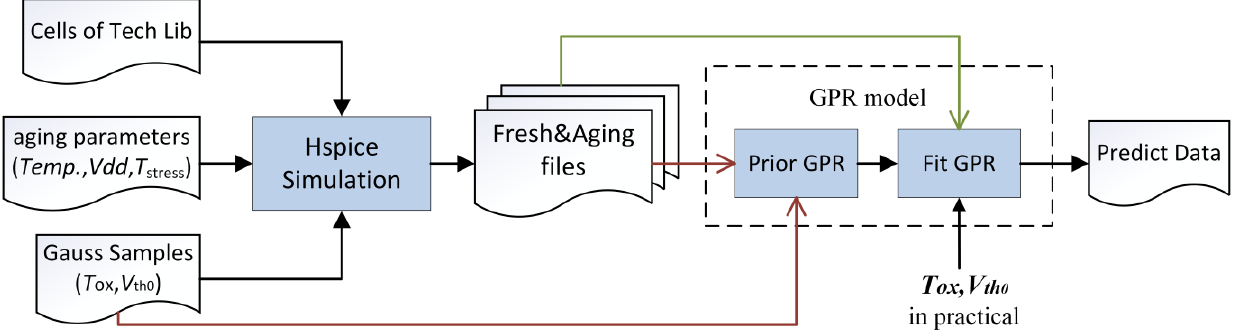
Figure 2. The overall GPR training and predicting process.